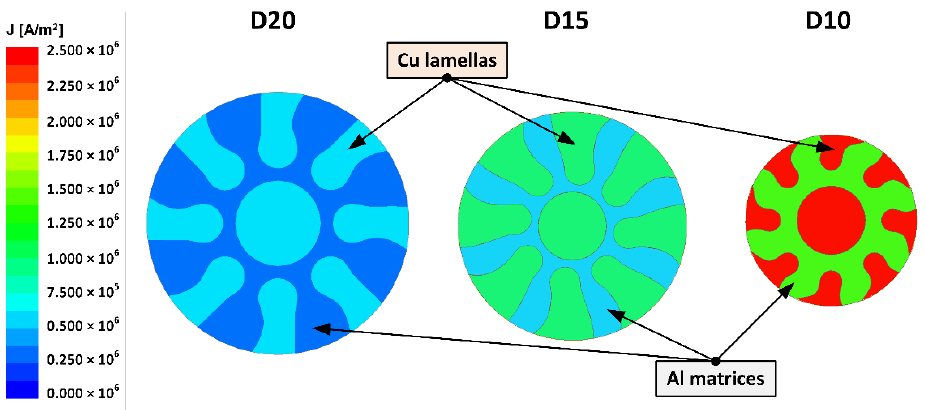
Figure 10. Numerically simulated distribution of current density across cross-sections of laminates swaged to 20 mm, 15 mm, and 10 mm (cross-sectional layouts of Al and Cu components based on geometries observed by SEM scanning of cross-sections of experimentally swaged laminates).